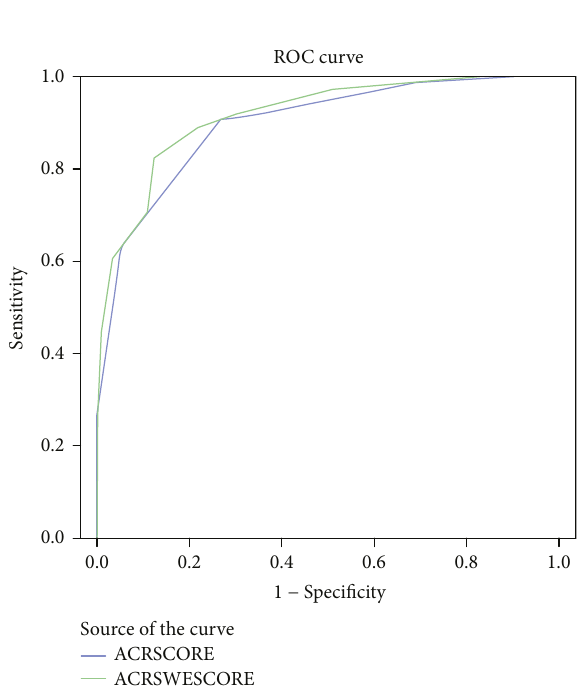
Figure 4: ROC curves of TIRADS and SWE +TIRADS score